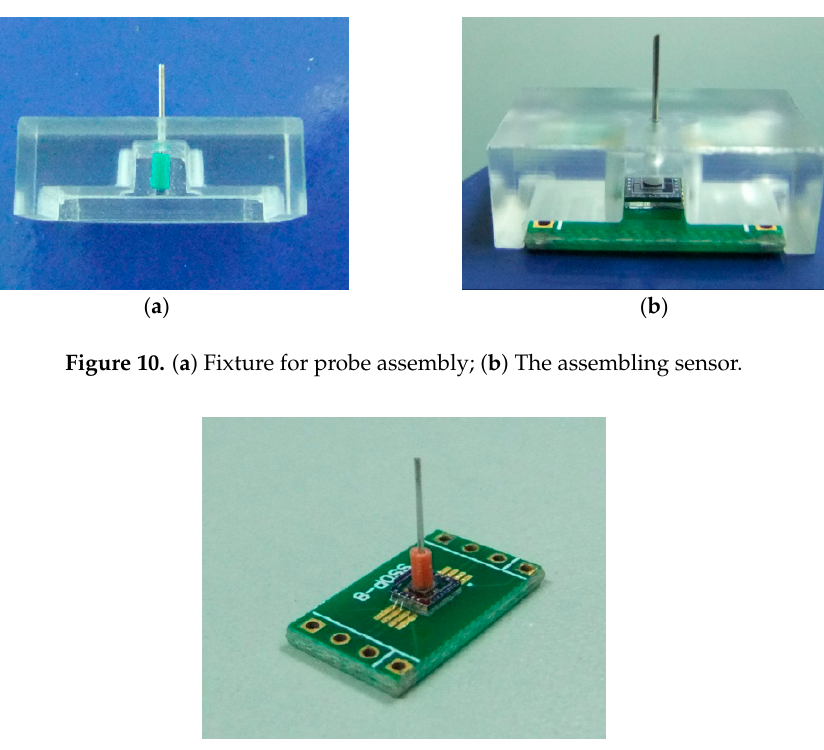
Figure 11. Prototype of the micro-force sensor.